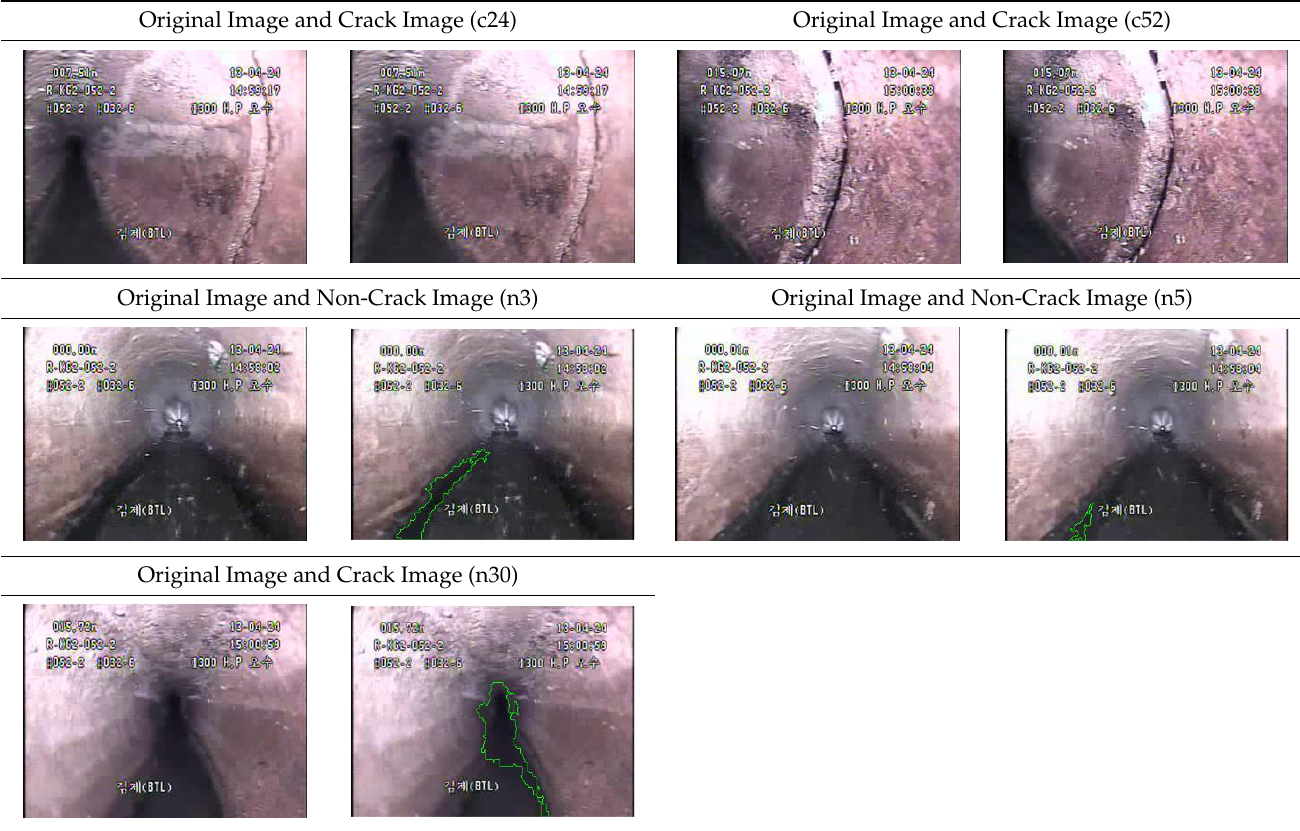
Table 14. Bad results of crack and non-crack images (all results).